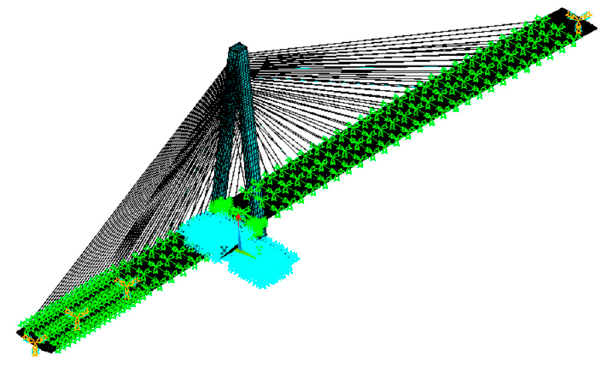
Figure 4. Finite element model of the single tower cable-stayed bridge.